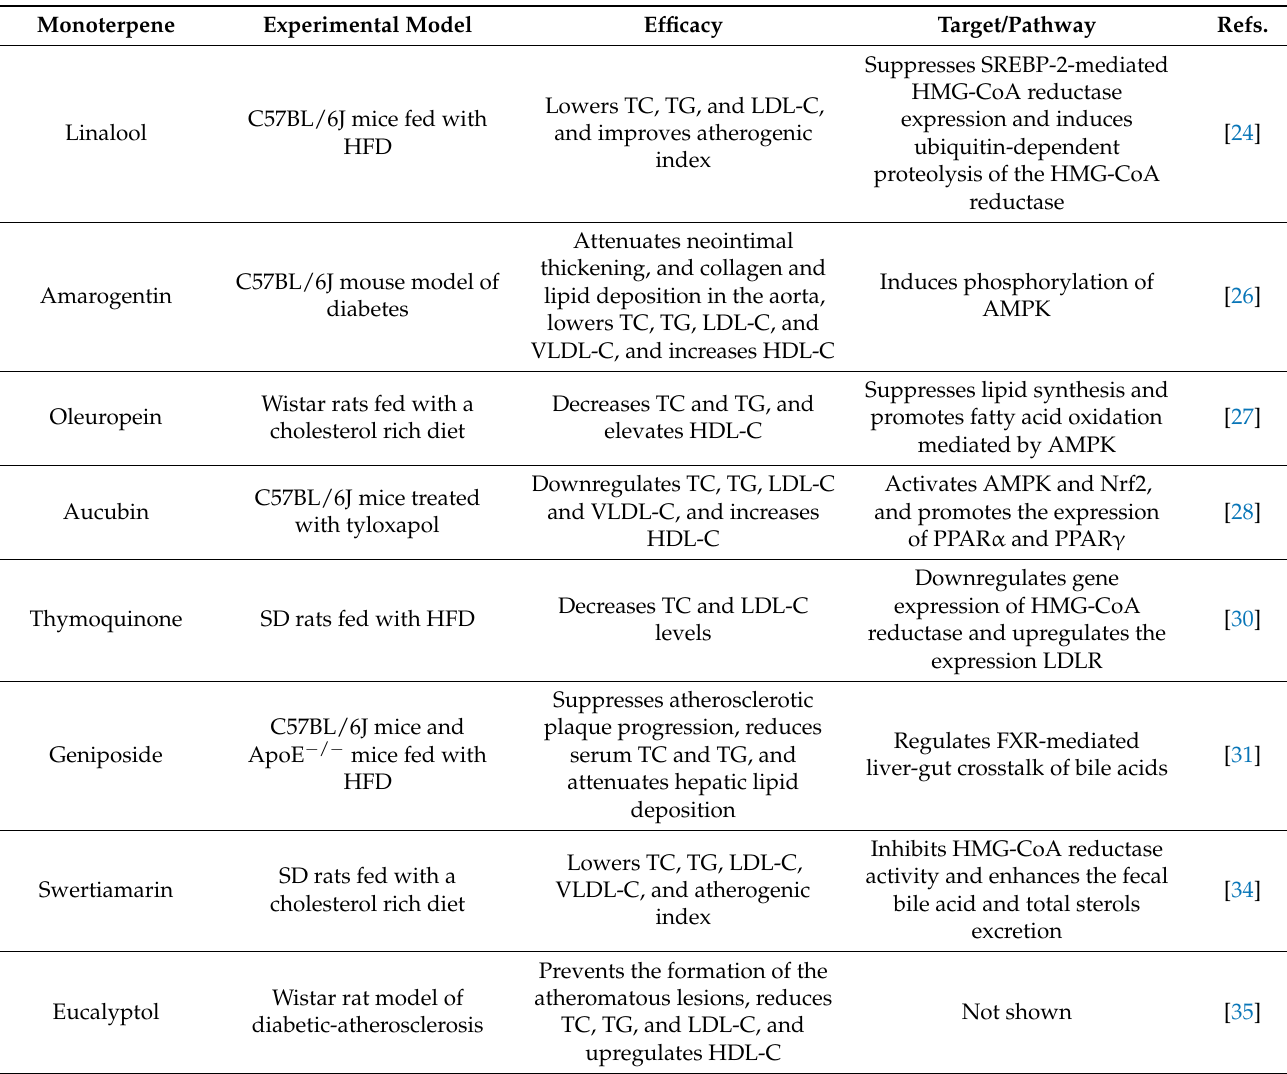
Table 1. Modulation of serum lipid